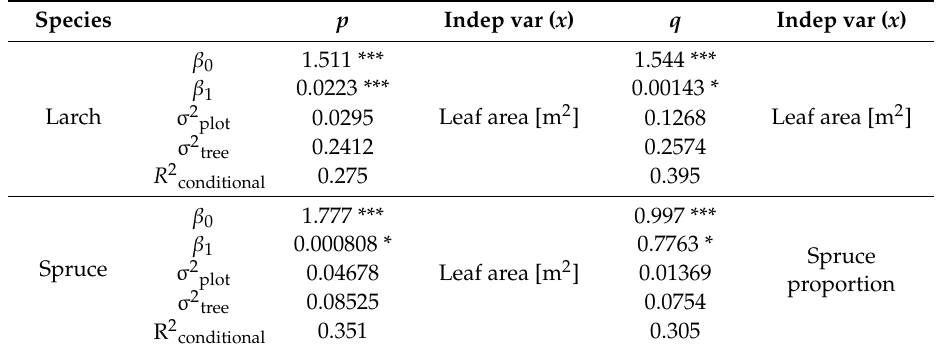
Table 5. The coe ffi cients and variances of the model in Equation (11). * and *** indicate the significance for type-one error probabilities of 5% and 0.1%, respectively.